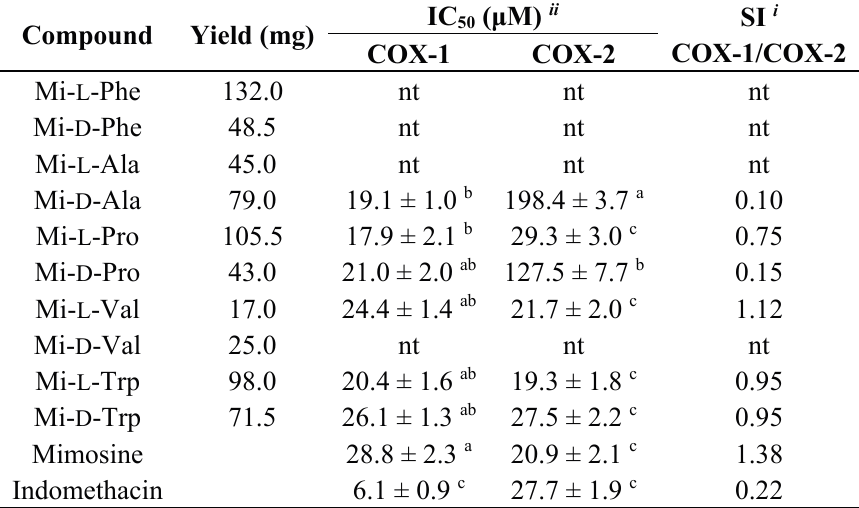
Table 4. IC 50 values of mimosine and their dipeptides for cyclooxygenase (COX) isoenzymes